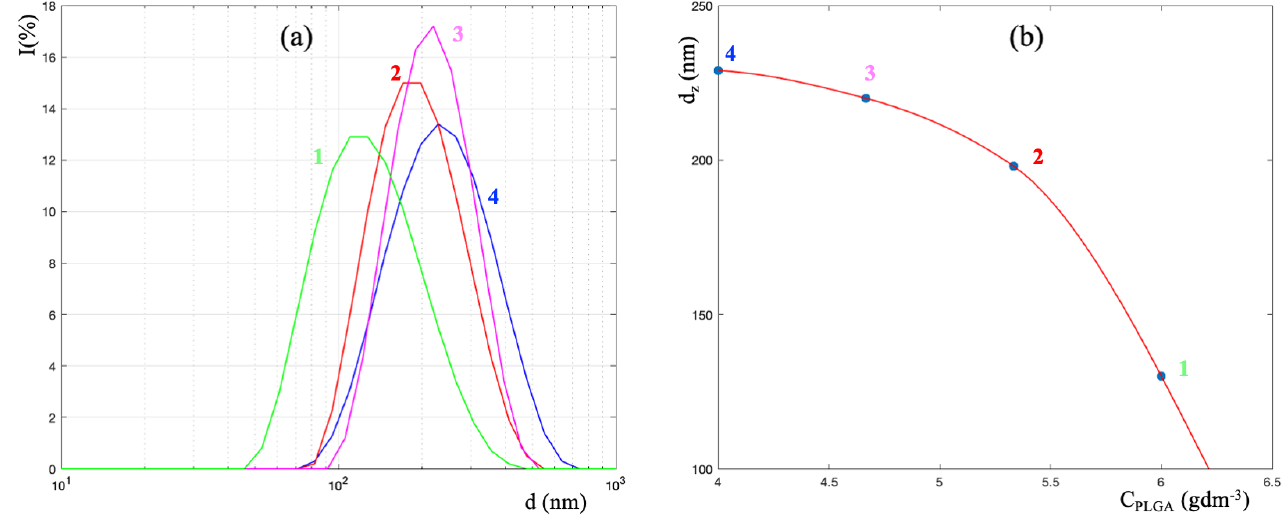
Figure 2. ( a ) Particle size distribution of PLGA nanoparticles obtained by nanoprecipitation. ( b ) Z-average of PLGA nanoparticles as a function of the polymer